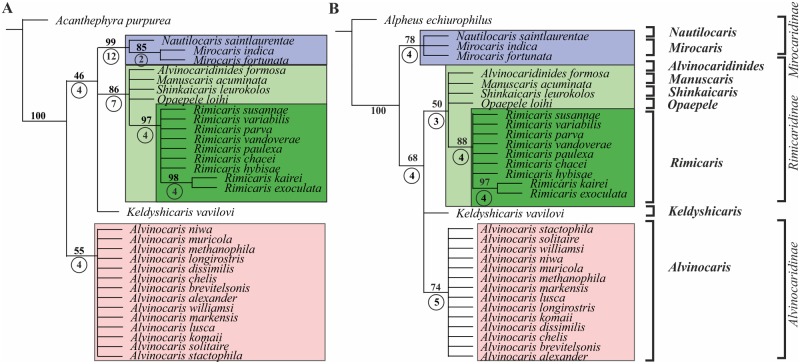
Statistically robust clades of Alvinocarididae with bootstrap support (numbers above the clade) and Bremer support (numbers below the clade in circles).A, analysis 1 with Acanthephyra purpurea as outgroup. B, analysis 2 with Alpheus echiurophilus as outgroup. Supported clades are marked by different colors: Mirocaridinae (blue), Alvinocaridinae (pink), Rimicaridinae (light green), Rimicaris (green).